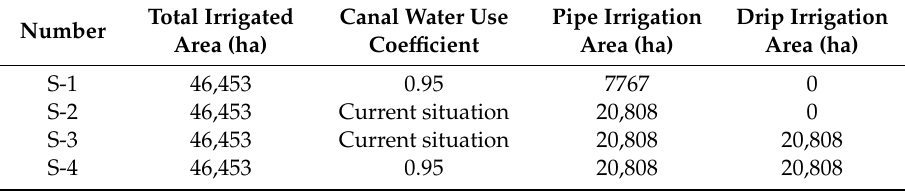
Table 5. Typical large-scale water-saving irrigation scenarios in Changma Irrigation